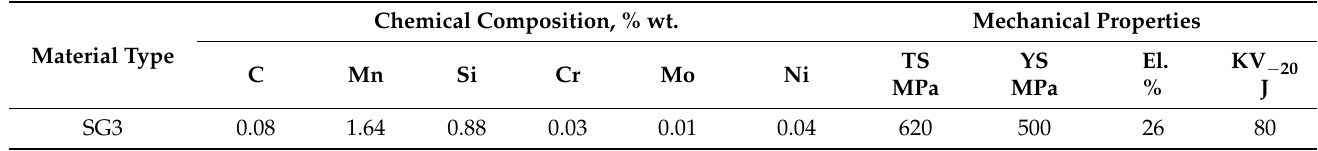
Table 3. Characteristics of SG3 filler metal based on the manufacturer’s certificate [21].